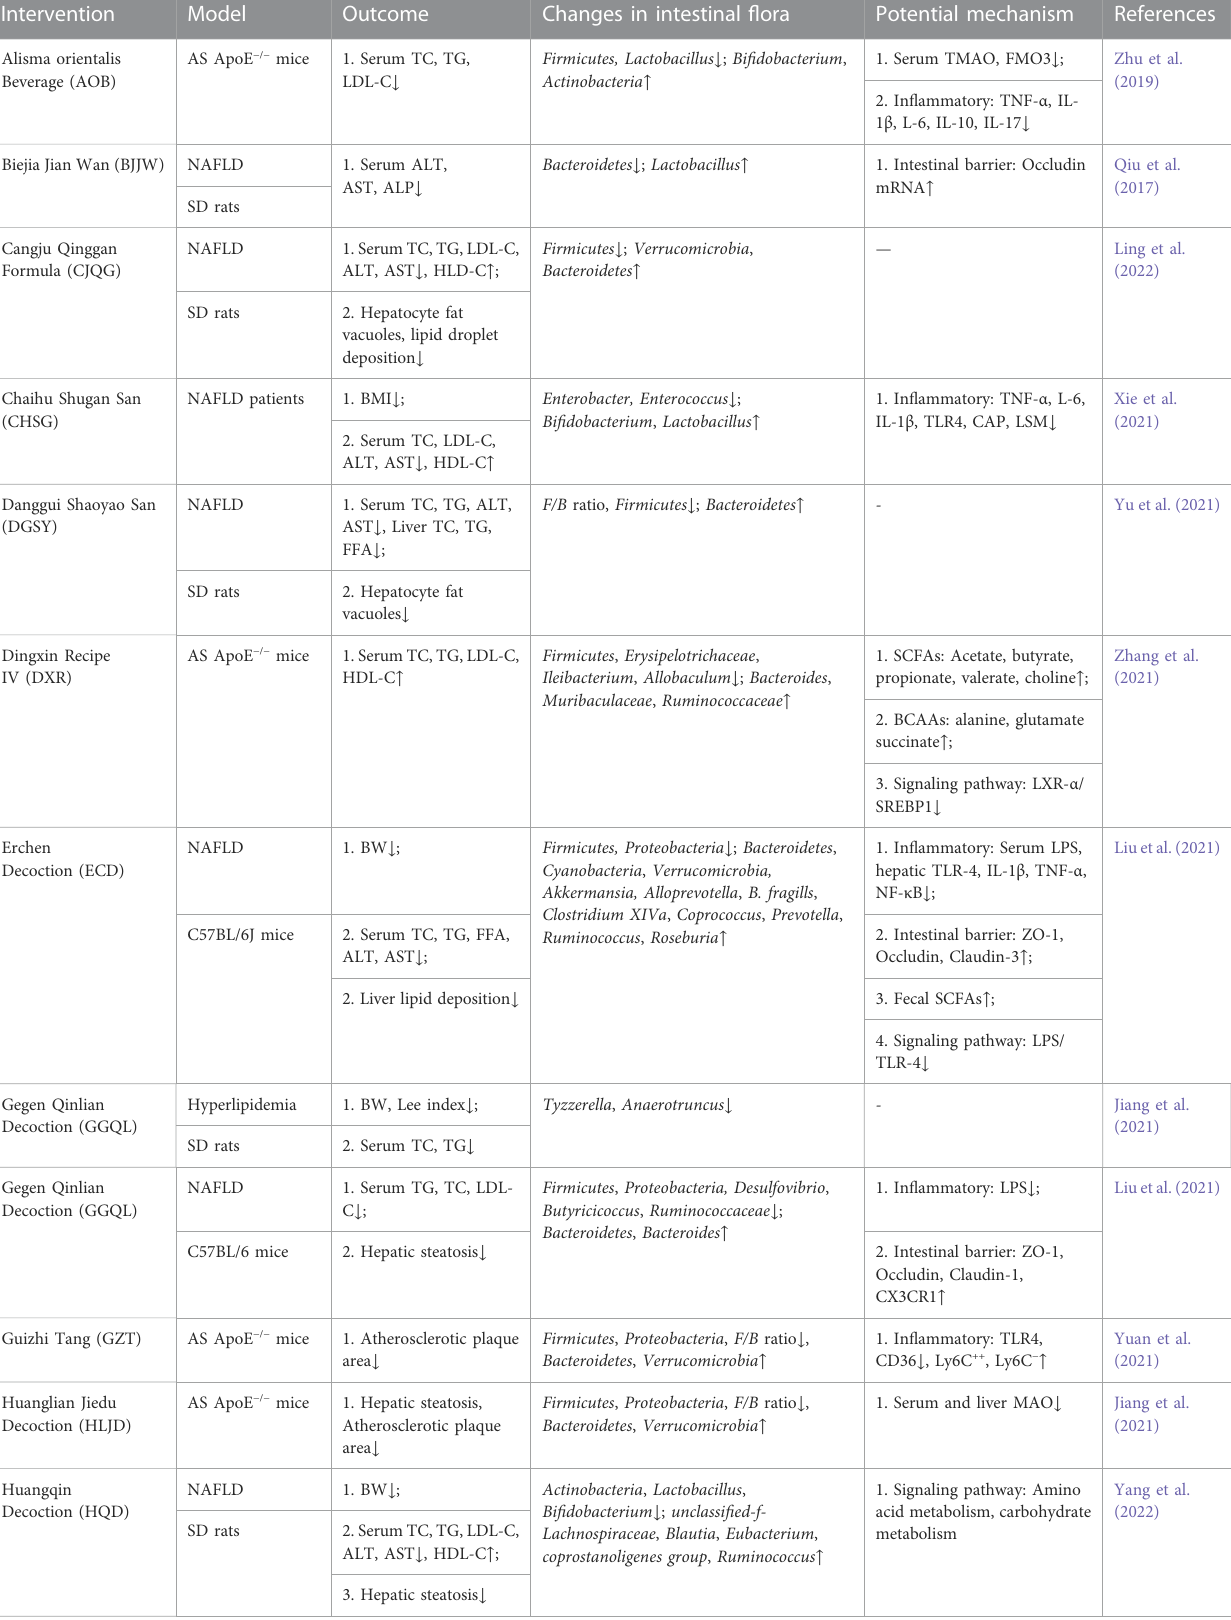
TABLE 1 Therapeutic effects of Chinese herbal formulas and proprietary Chinese medicines on